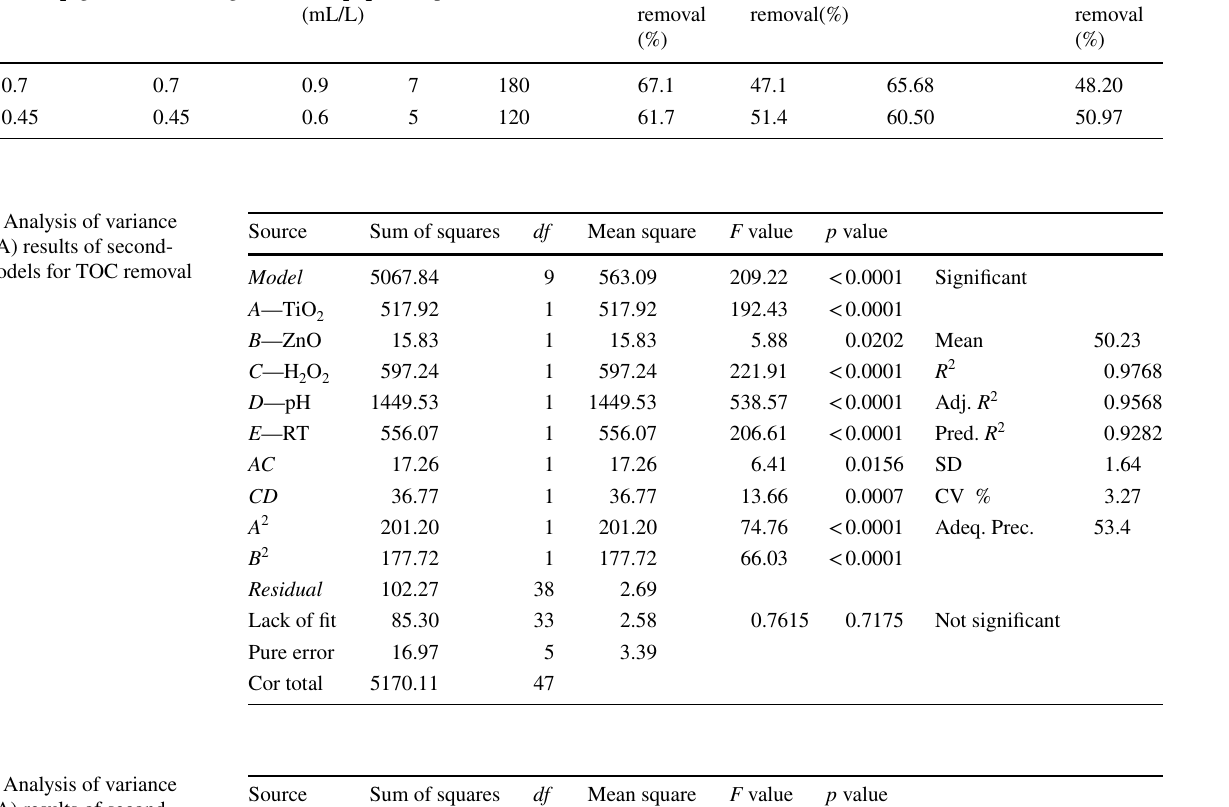
(ANOVA) results of second- order models for COD